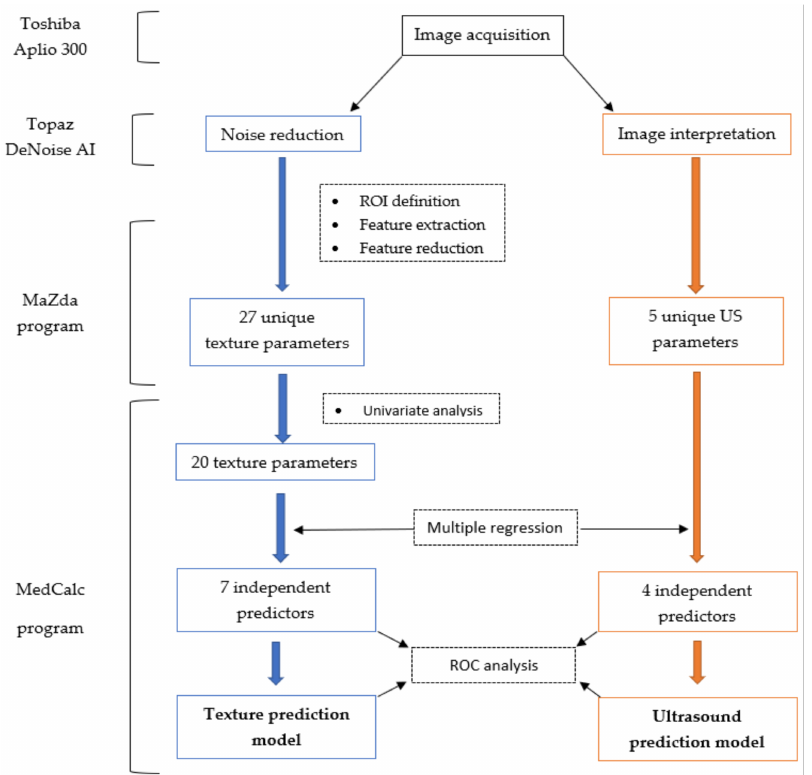
Figure 2. Workflow model summarizing the construction of the texture (blue) and ultrasound (orange) prediction models. US, ultrasound; ROI, region of interest; ROC, receiver operating